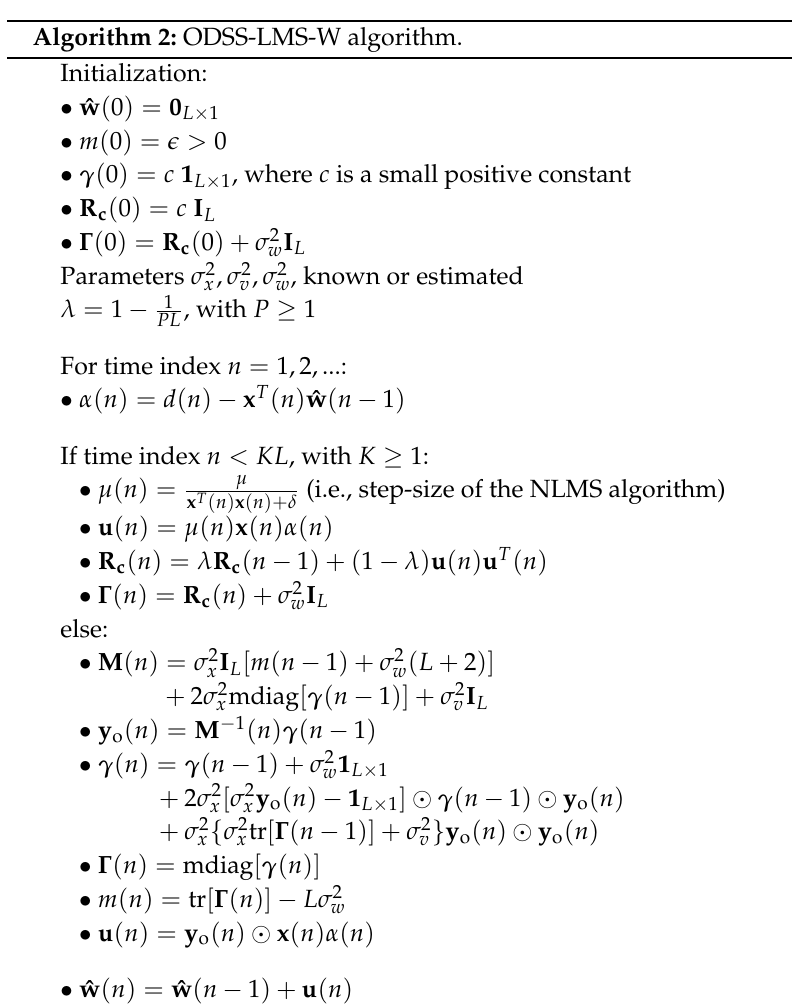
Algorithm 2: ODSS-LMS-W